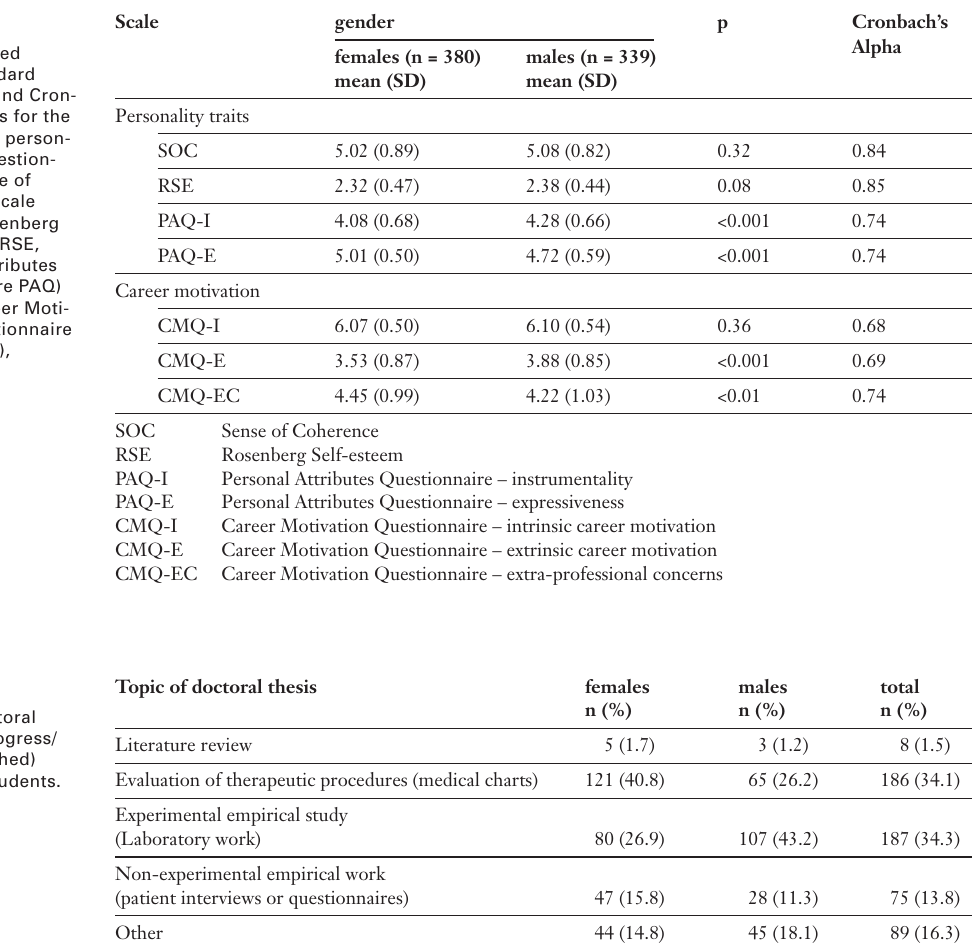
Chi-square = 21.6, p <0.001